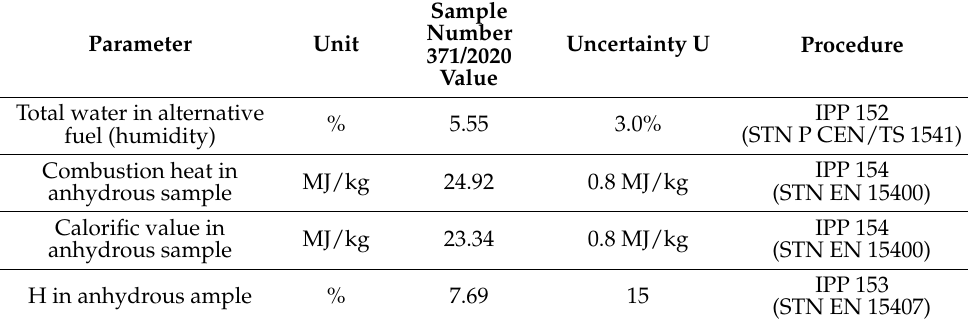
Table 3. Solid recovered fuel test results, supplied by RAMEKO, Ltd.